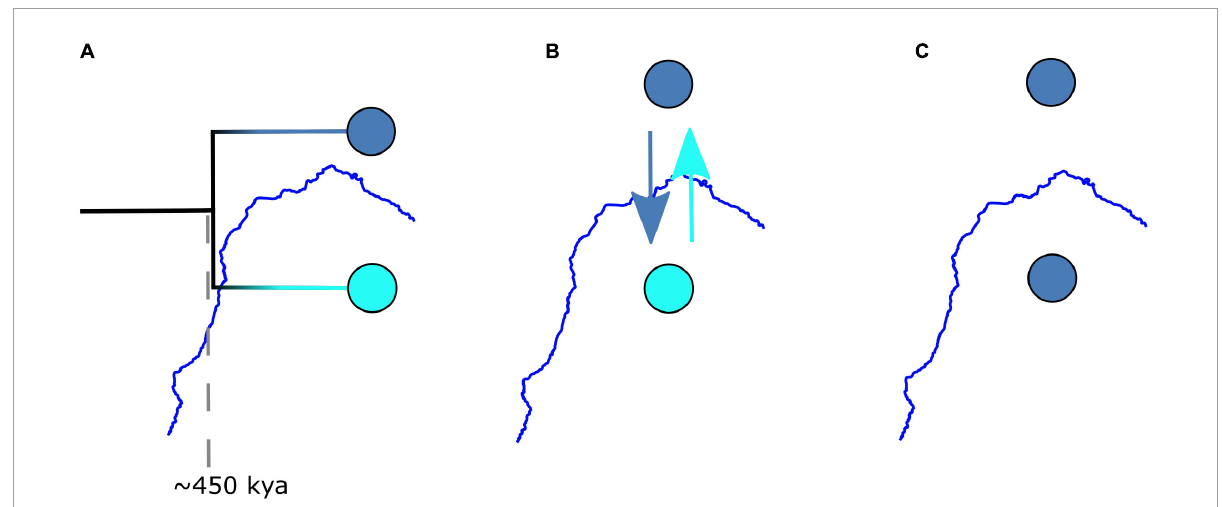
FIGURE2 Representation of models tested to explain the phylogeographic history of species distributed on both sides of the São Francisco River (blue line). (A) Isolation model in which the river acts as a strong barrier isolating groups with no gene flow beginning at ∼ 450 kya. (B) Migration model in which the river acts as a soft barrier, allowing migration across the river with no divergence time. (C) Panmictic model, in which the river is not a barrier and populations interbreed